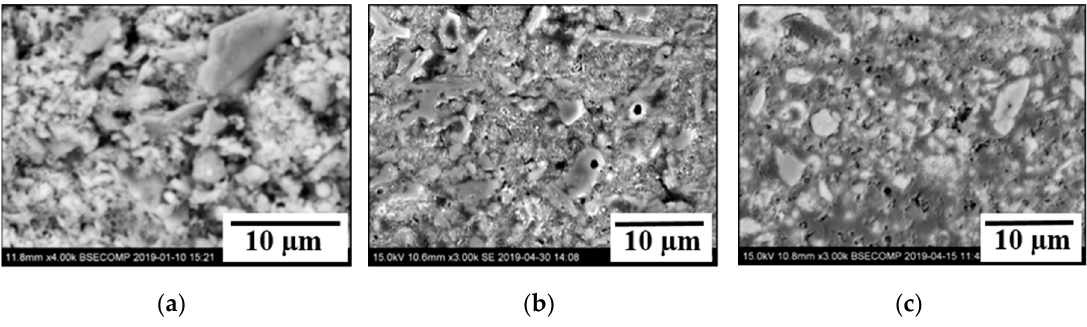
Figure 10. Typical SEM images of small particles in fly ash powder ( a ) and in F80 briquettes before ( b ) and after ( c ) heat treatment at 850 °C.